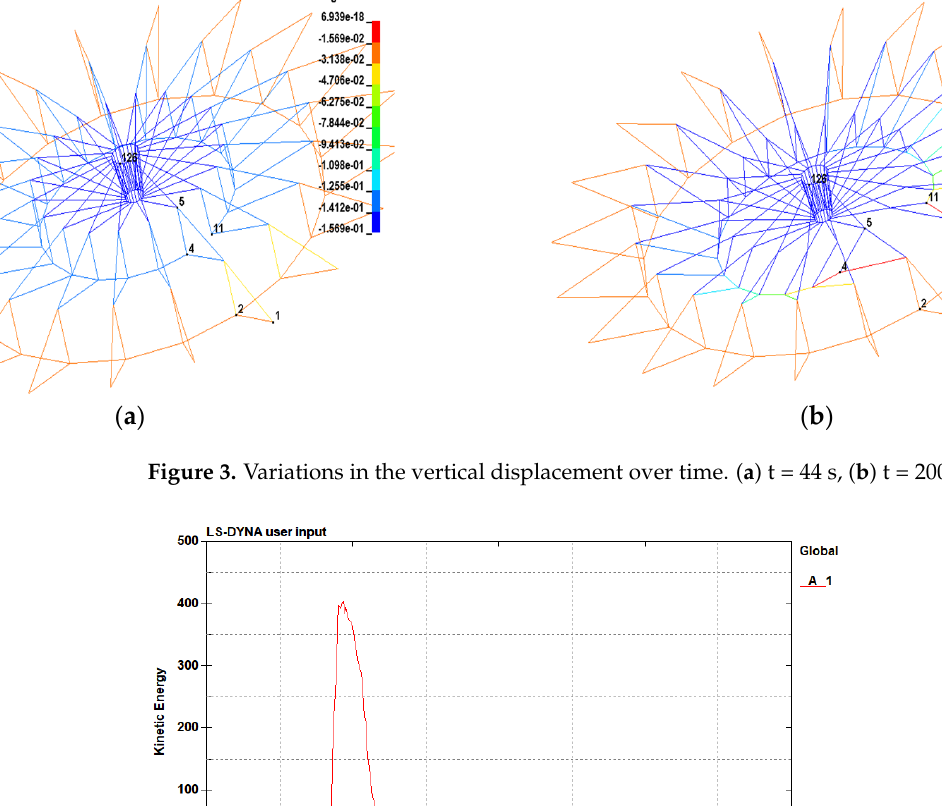
Figure 3. Variations in the vertical displacement over time.